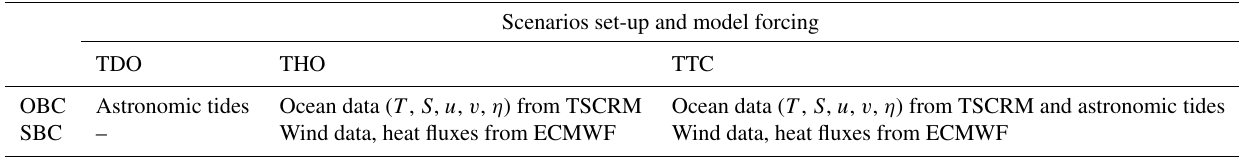
Table 1. SHYFEM forcing data, including open boundary conditions (OBC) and surface boundary conditions (SBC) adopted in the three numerical experiments TDO, THO and